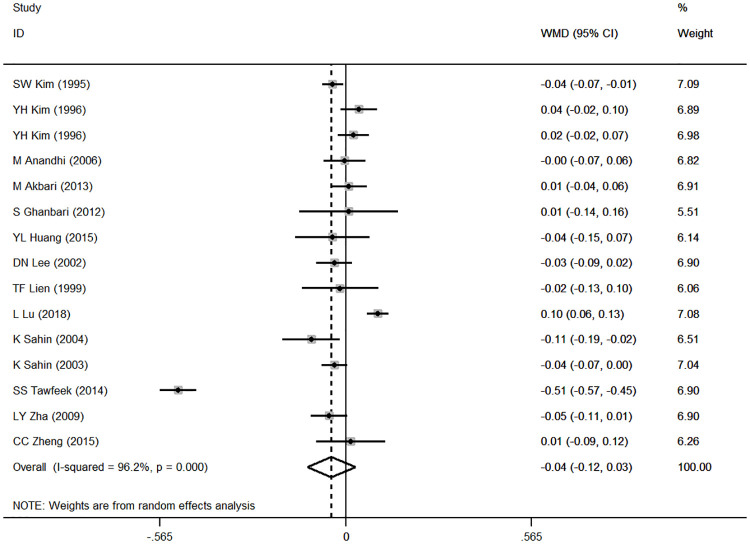
Forest plot of FCR.